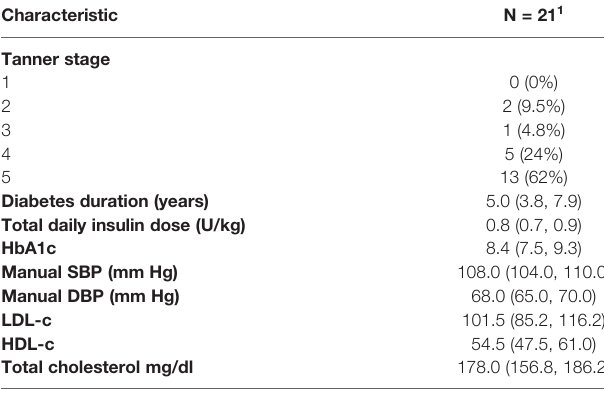
TABLE 2 | Baseline clinical characteristics of study